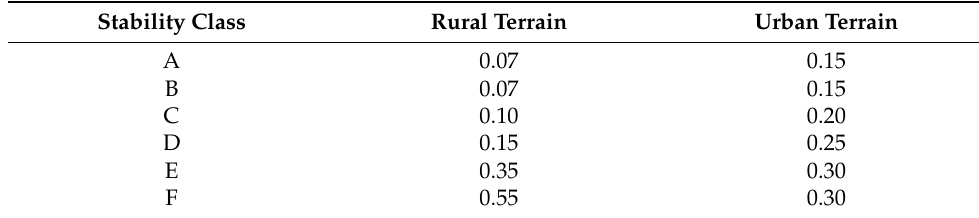
Table 1. Values of β in predicting the wind speed